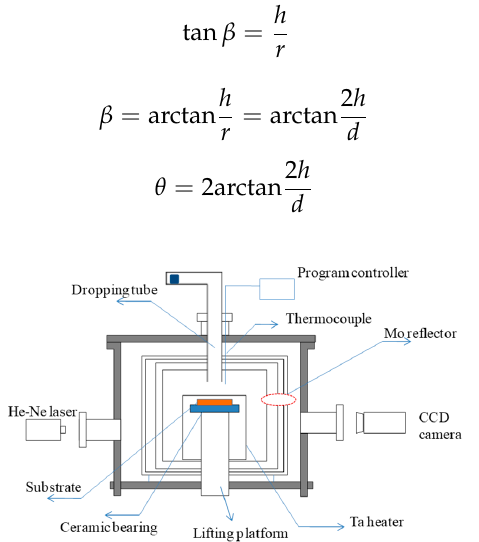
Figure 2. Schematic illustration of equipment used for the sessile drop experiment.